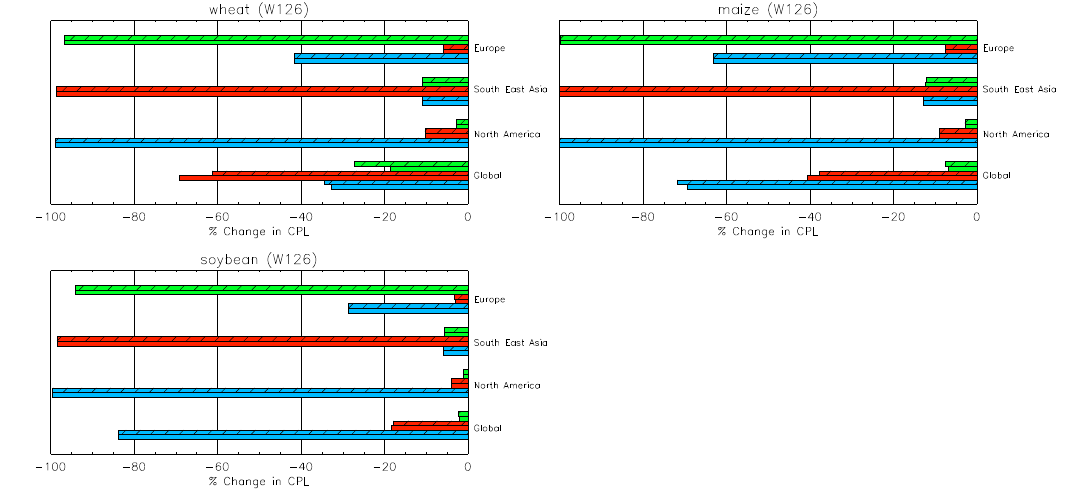
Fig. 12. As Figure 10, but using the W126 metric for 3 of the